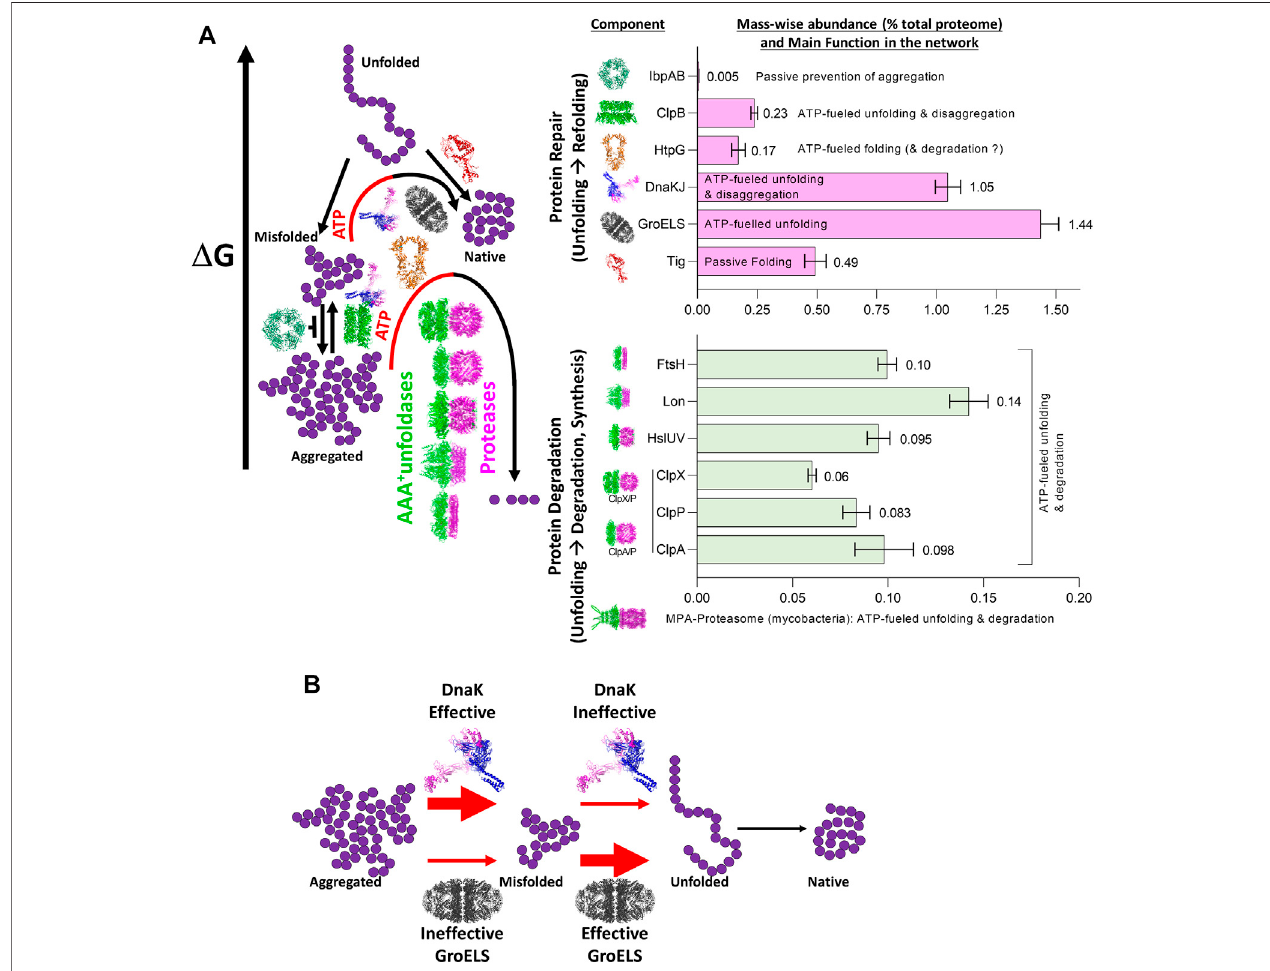
FIGURE 2| The role ofthe main bacterial chaperonesand proteases. (A) Leftpanel: The main folding states ofa polypeptide arranged byfreeenergy, as shown in Figure 1 . Whereas trigger factor (Tig) passively drives the native folding of unfolded polypeptides exiting the ribosome and HSP20 passively prevents misfolding and aggregation, GroEL, DnaK and ClpB can inject energy from ATP hydrolysis into the expansion of collapsed misfolded and aggregates species. HtpG may use ATP hydrolysistocompletethenativefoldingofslow-foldingintermediatesfromDnaK-DnaJandfailingthat,maypromotetheirdegradationbyproteases(Honoréetal., 2017; Fauvet et al., 2021). The bacterial proteases are gated by N-terminal chaperone-like AAA+ rings (green) that can unfold stable aggregates and thread them into a protease central cylinder (magenta), to be speci fi cally degraded. Right panel: mass-wise abundances of chaperones and proteases from the protein homeostasis network; data from (Fauvet et al., 2021) (B) Example of synergism between bacterial HSP70 (DnaK) being effective (red thick arrow) at dismantling aggregates into individual misfolded polypeptides, but ineffective (red thin arrow) at unfolding individual misfolded polypeptides into natively refoldable species, and the bacterial Hsp60 system (GroELS) being ineffective at dismantling aggregates into individual misfolded polypeptides but being highly effective at unfolding individual misfolded polypeptides into natively refoldable species (thick black